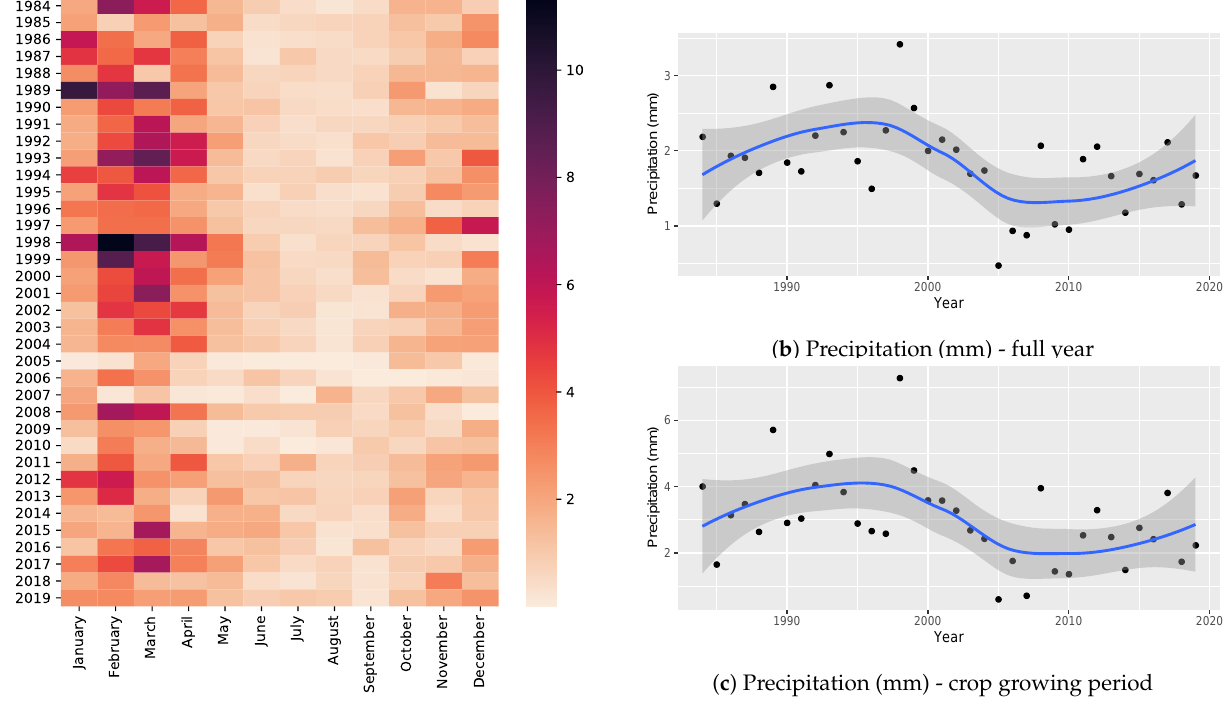
Figure 4. Time series of daily average precipitation (mm) in Loja from 1984 to 2019. ( a ) Heat-map of daily precipitation (mm) per each month and year. The color scale represents the precipitation in mm. ( b ) Daily precipitation averaged during the full year. ( c ) Daily precipitation averaged during the maize crop growing period in Ecuador (January–May). Each dot represents one record, the blue line shows the smoothed time series and the shaded area represents the 95% confidence